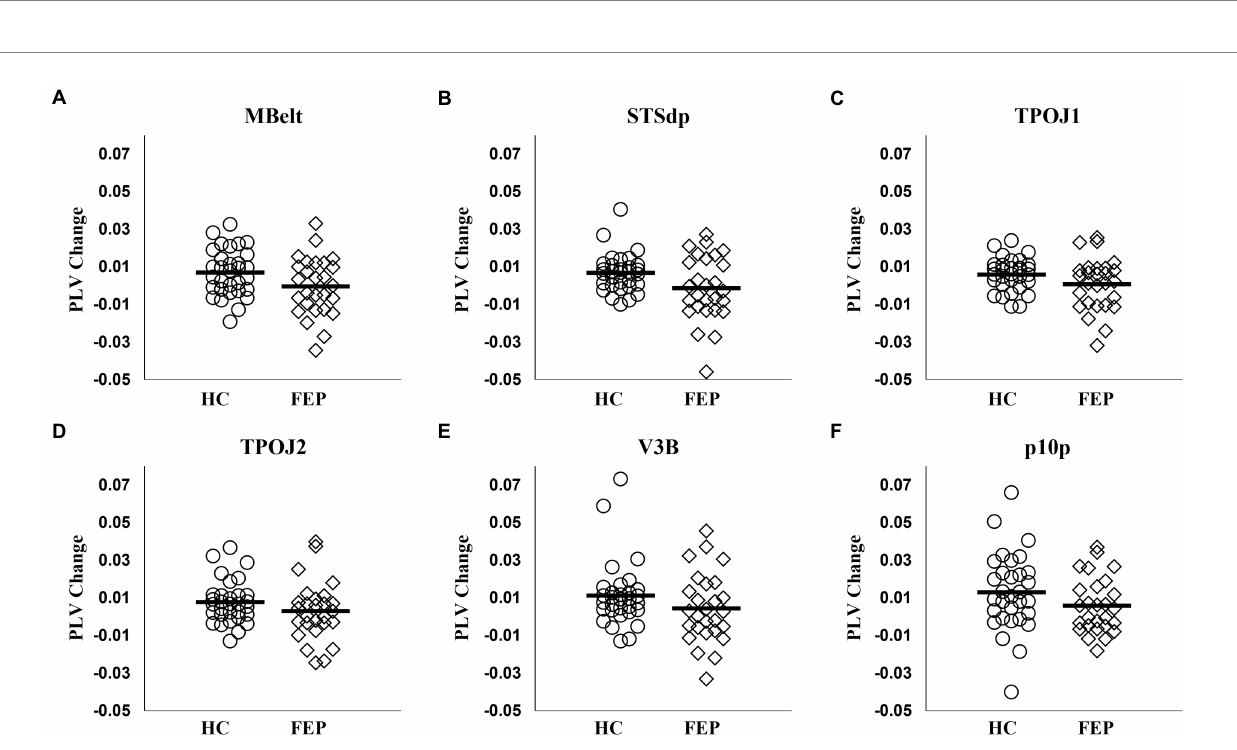
FIGURE 7 Left hemisphere network connectivity changes in HC and FEP. There was a significant reduction in the modulation of theta band connectivity with attention (measured with change in phase-locking value) across regions in the left hemisphere network in FEP (A–F) .